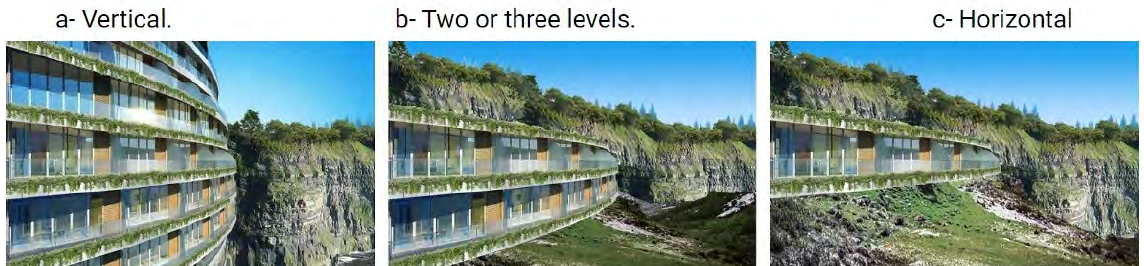
Figure 6. The extension direction possibilities for an Earth-sheltered neighborhood. The horizontal and two or three levels are acceptable.